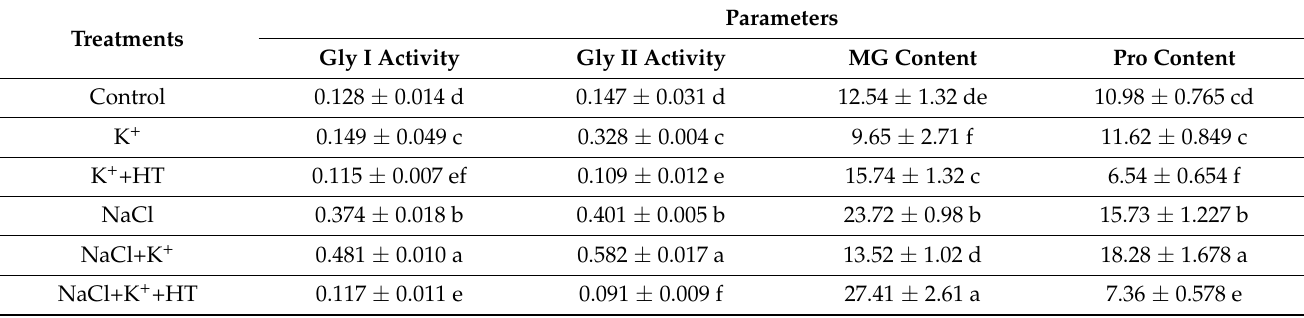
Table 2. Effect of potassium (K + ) and NaCl on the components of glyoxalase system and proline content. Activity of glyoxalase I/II (Gly I/Gly II, nmol min − 1 mg − 1 protein), methylglyoxal (MG, µ mol g − 1 FW) content, and proline (Pro, mg g − 1 DW)